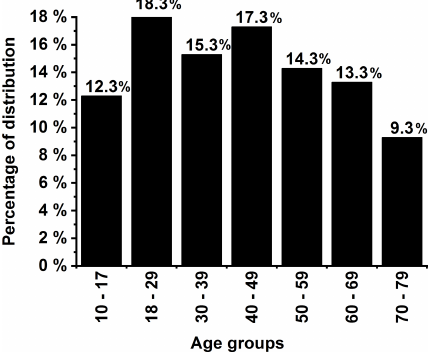
Figure 1. Age distribution assigned for the pedestrian agents in the flood–pedestrian simulator based on the UK’s national survey (UK population by ethnicity,